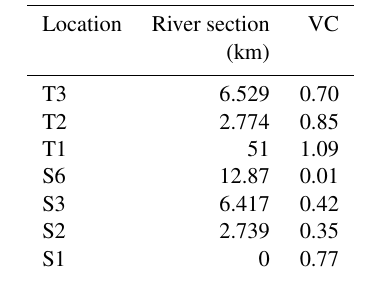
Table 4. Variability coefficient (VC) for selected locations along the Sulden and Trafoi River in 2014 and